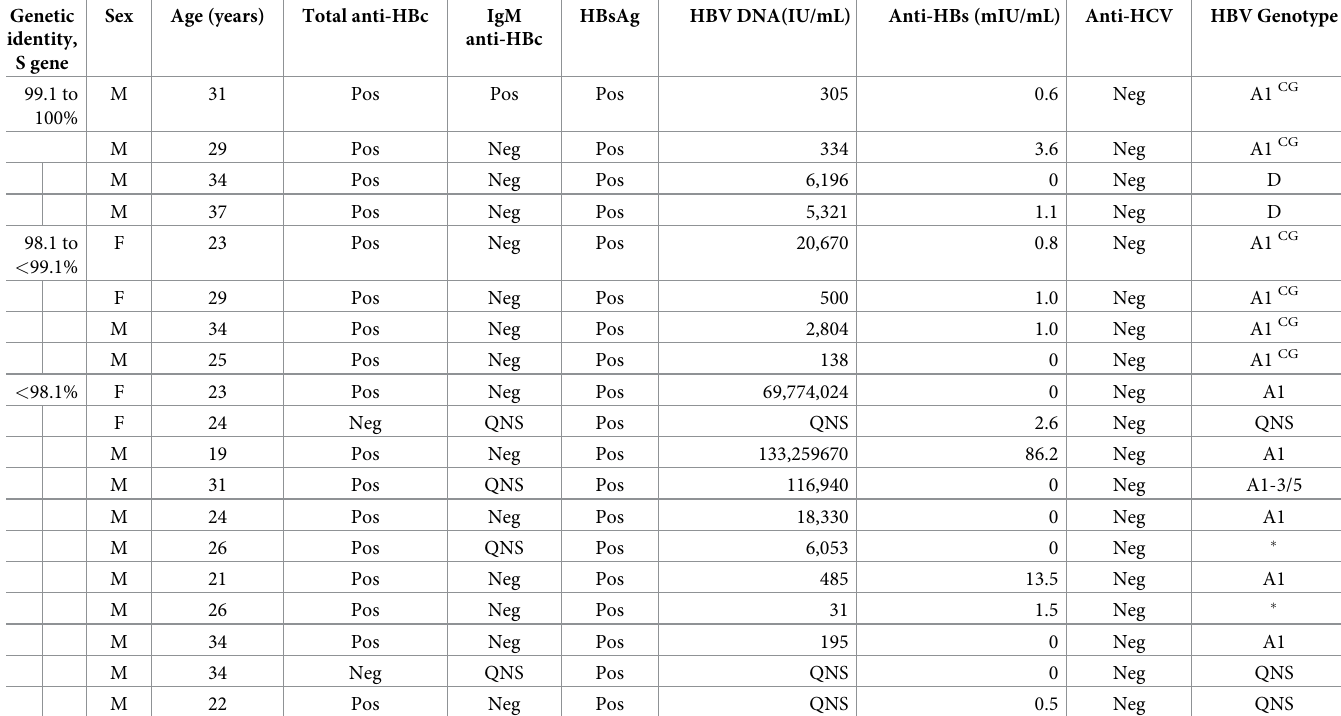
Table 1. Serology and genetic identity of hepatitis B virus infections identified among military forces in the 2011 Guyana Defence Force Seroprevalence and Behav- ioral Epidemiology Risk Survey for HIV and sexually transmitted infections (n = 19). Genetic identity,